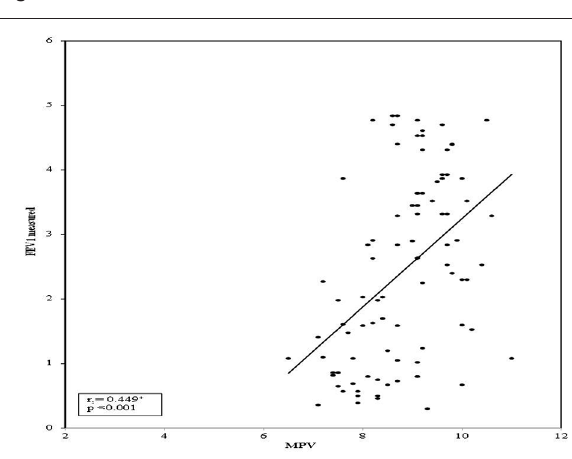
Table 3: Correlation between MPV and FEV1 measured for total sample ( n = 90) FEV1 measured 0.449* * : Statistically significant at P ≤